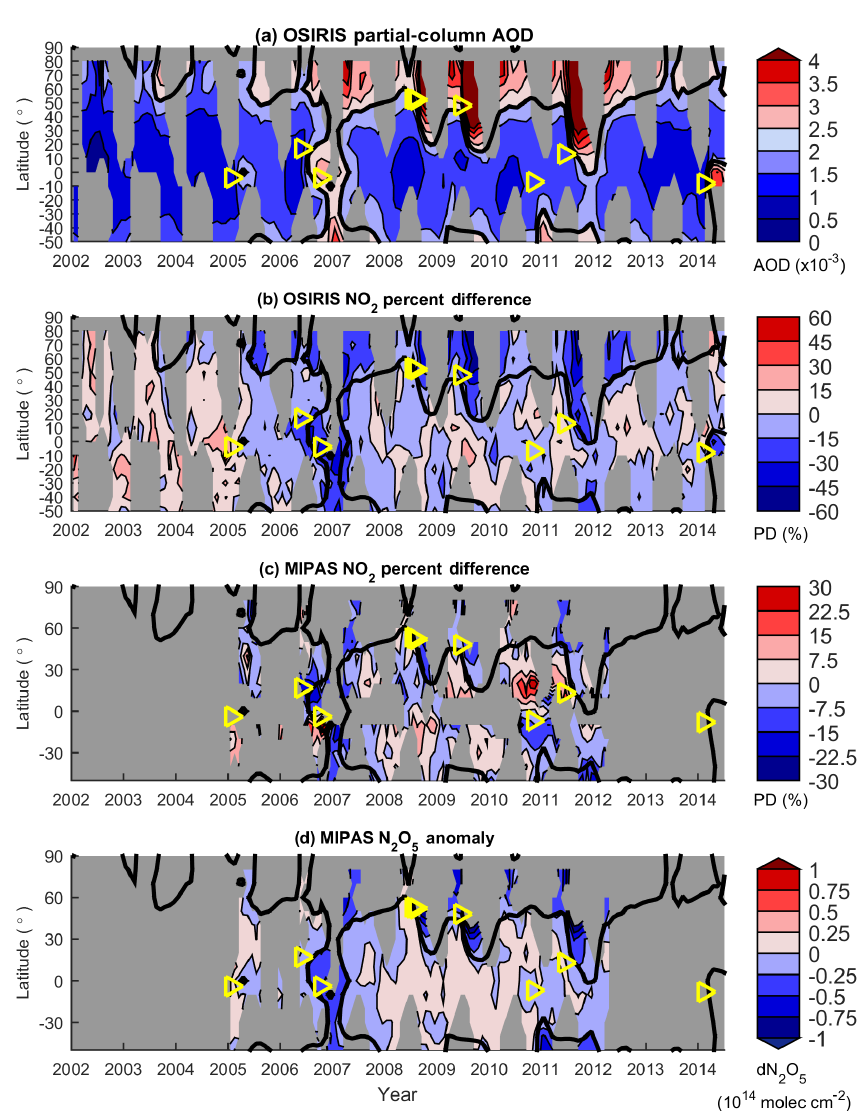
Figure 3. Contour plots of time ( x axis) versus latitude ( y axis) versus (a) OSIRIS partial-column AODs, (b) percent difference of OSIRIS NO 2 VCDs, (c) percent difference of MIPAS NO 2 VCDs, and (d) MIPAS N 2 O 5 anomaly. The partial-column AODs and VCDs are cal- culated for a 5km layer starting ∼ 3km above the thermal tropopause. Percent differences are relative to background levels of NO 2 . Note that different color-scale ranges are used for OSIRIS and MIPAS NO 2 percent differences. The thick black contour lines show OSIRIS AOD = 2 × 10 − 3 extrapolated to latitudes and times for which data were unavailable. The yellow triangles indicate the volcanic eruptions that were followed by significant increases in OSIRIS aerosol extinction, as listed in Table